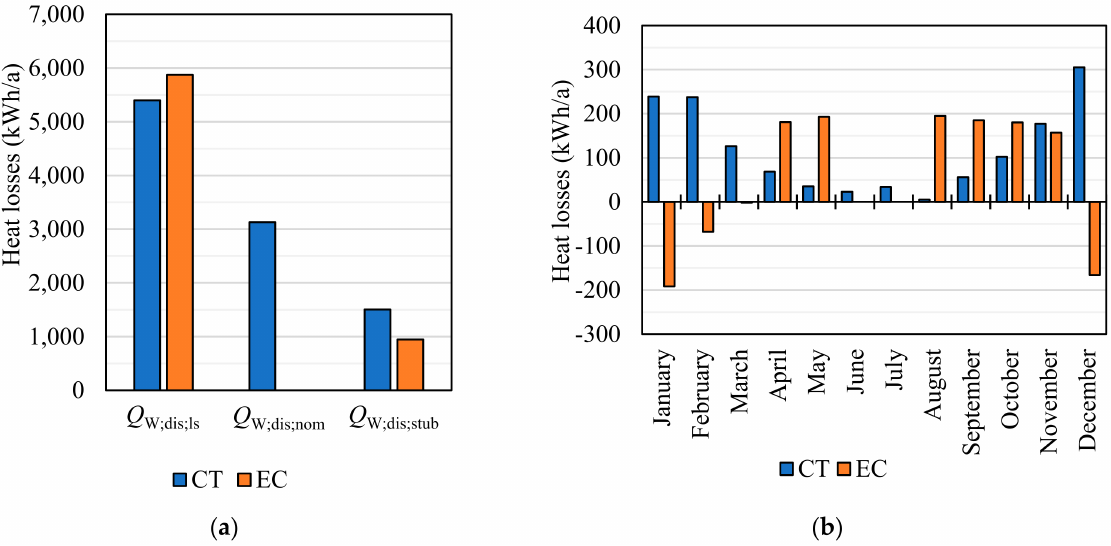
Figure 17. Comparison of: ( a ) DHW distribution subsystem, and ( b ) boiler heat